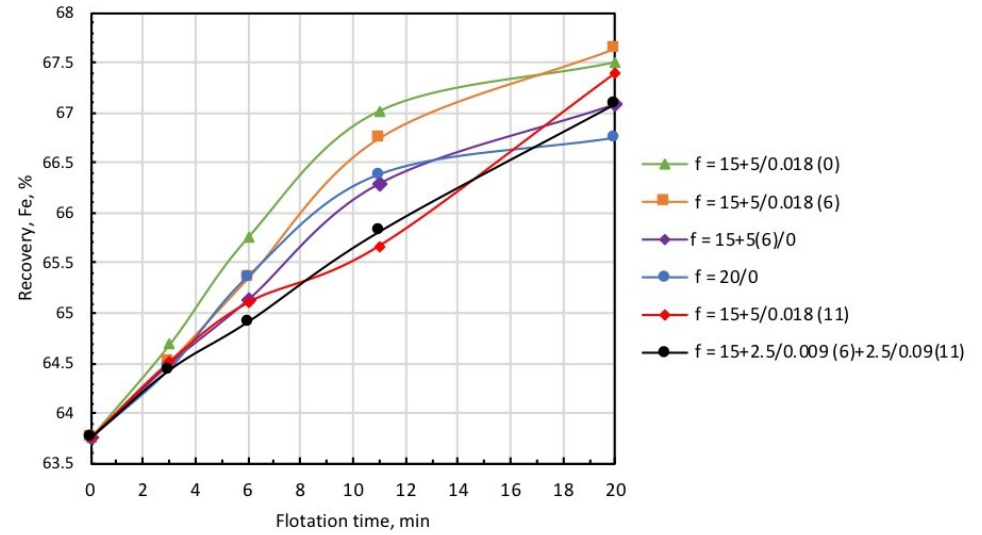
Figure 13. Concentrate grade at different modes of collector and microbubble introduction (symbols are explained in Table 3).